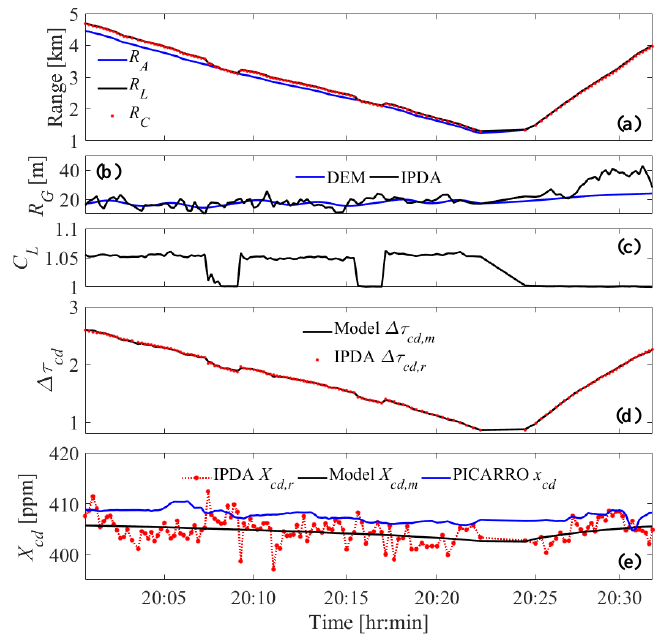
Figure 18. Airborne pulsed 2-μm IPDA lidar measurement and retrieval results during Spiral 2 conducted after sunset. ( a ) Airborne altitude, R A , as compared to LOS, R L and IPDA column measurement, R C . ( b ) Estimated ground elevation, R G , as compared to DEM results. ( c ) Corresponding C L profile used for converting R A to R L . ( d ) IPDA Δ τ cd measurement after processing and 10-s (500 shots) average, Δ τ cd,r compared to model Δ τ cd , Δ τ cd,m , obtained from MGD. ( e ) IPDA retrieved XCO 2 , X cd,r , compared to model driven XCO 2 , X cd,m and corresponding x cd in situ measurements. Results obtained using 2 GHz and 5.5 V e-APD bias voltage.